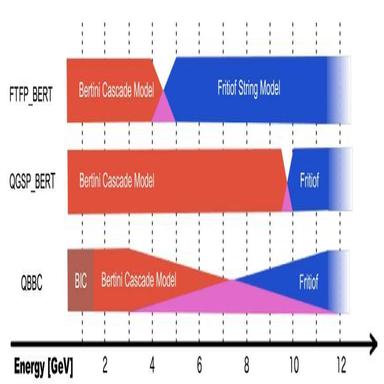
Event display of a −-meson interaction with an energy of 10 GeV (a) before and (b) after removal of the interaction region. Smaller cubes are pads that are part of the interaction region and are not processed by the track-finding algorithm. In this event the hits in the first ten layers are classified as hits left by the incoming −-meson.